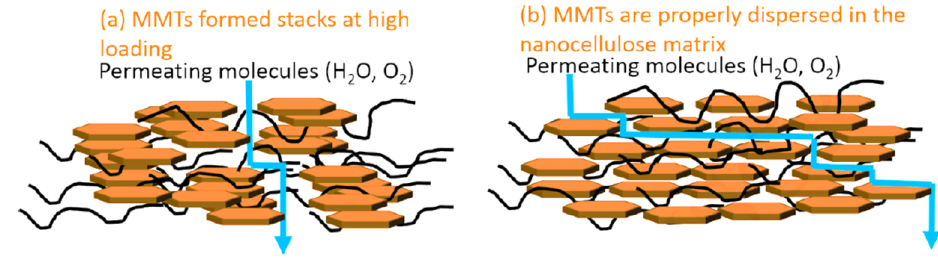
Figure 8. Mechanism of MMT stacking and arrangement of stacks in nanocellulose network. ( a ) MMT stack formation at high loading level which decrease the tortuous path; ( b ) MMT stacks broken down using high-pressure homogenization of nanocellulose/MMT suspension which increase the tortuous path [183]. MMT = montmorillonite. Reproduced with permission from Elsevier.